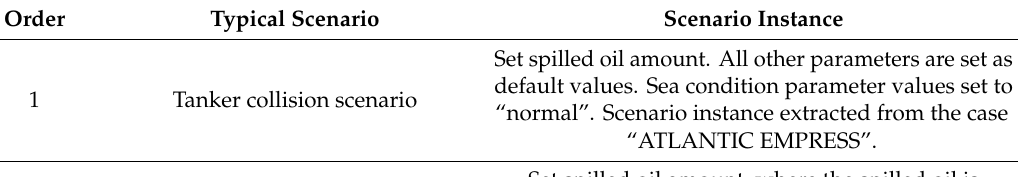
Table 4. Four typical scenarios (with five scenario instances) in the